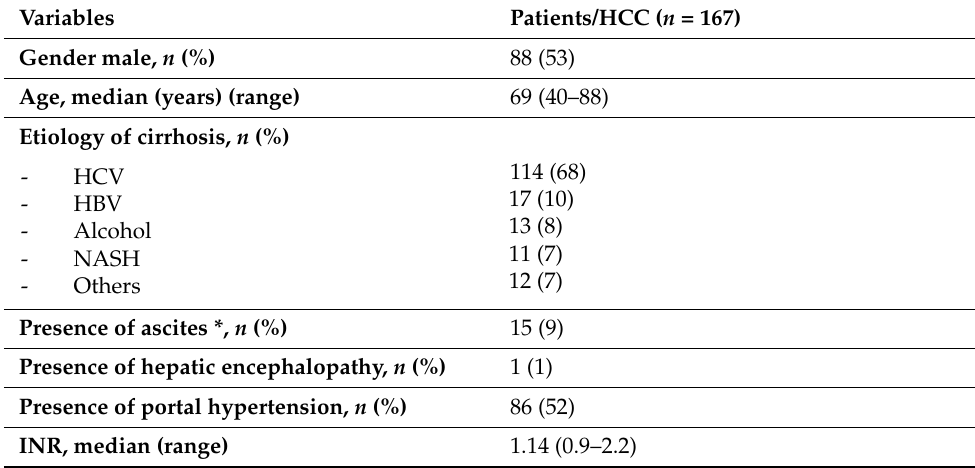
Table 1. Patients and HCC